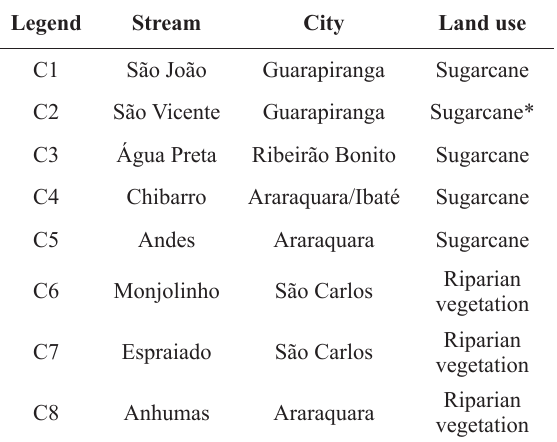
General characteristics of the eight sampling sites, showing the land use types and